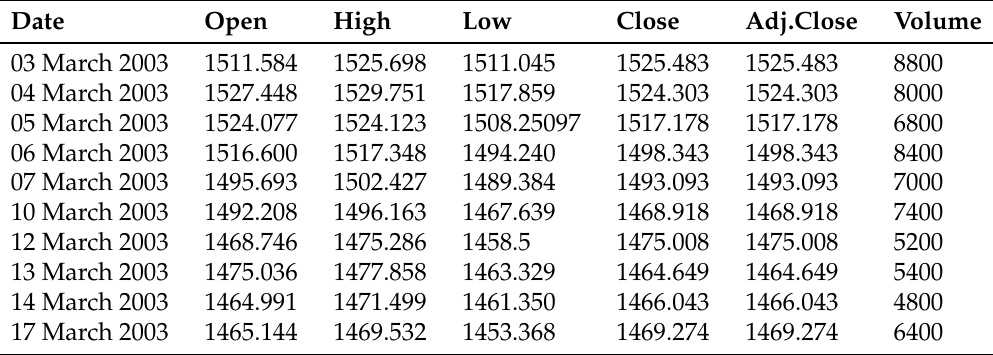
Table 2. Shanghai Composite Index (000001) Data Set.